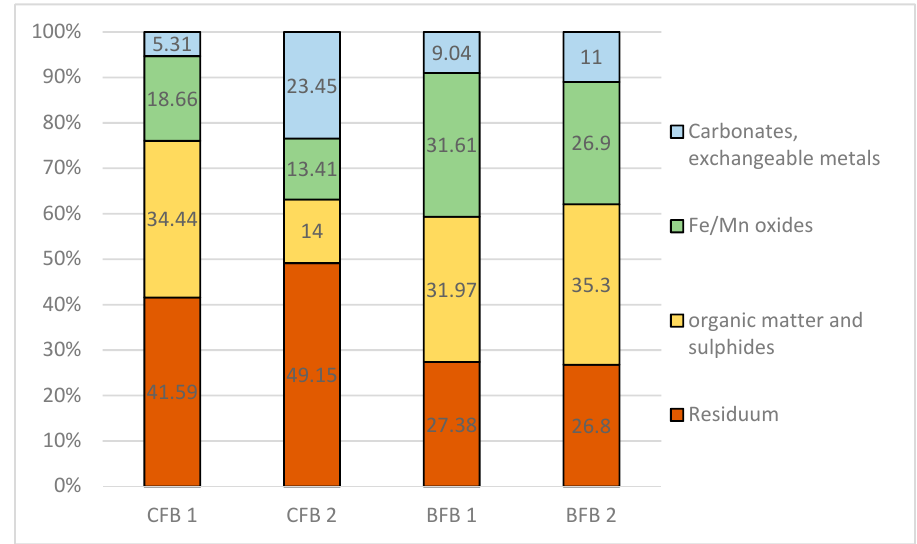
Figure 3. Speciation of Zn in fly ash.